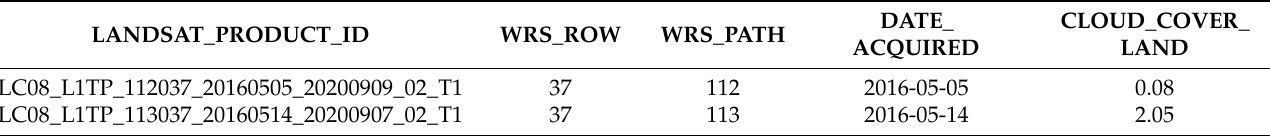
Table 2. Landsat 8 data information of study